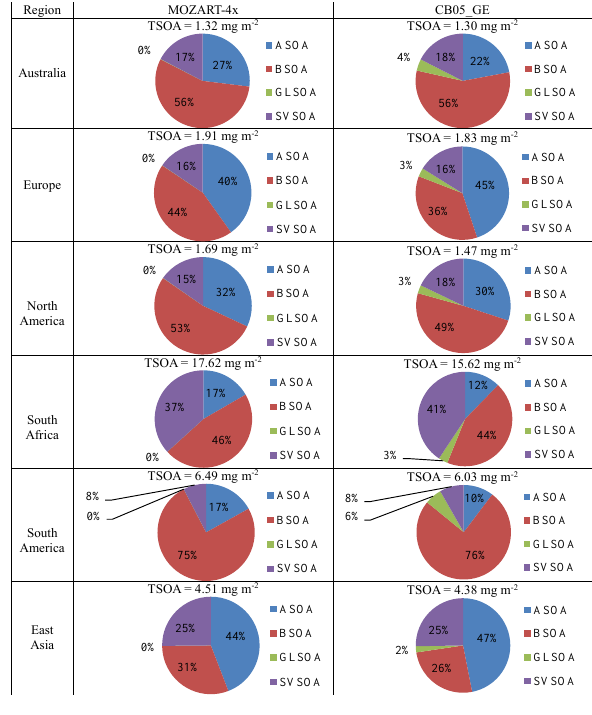
Figure 9. Column abundances (mgm − 2 ) averaged during 2008– 2010 of secondary organic aerosols (SOA) from anthropogenic sources (ASOA), biogenic sources (BSOA), and glyoxal (GLSOA), and semi-volatile organic aerosol (SVSOA) over Australia, Europe, North America, South Africa, South America, and East